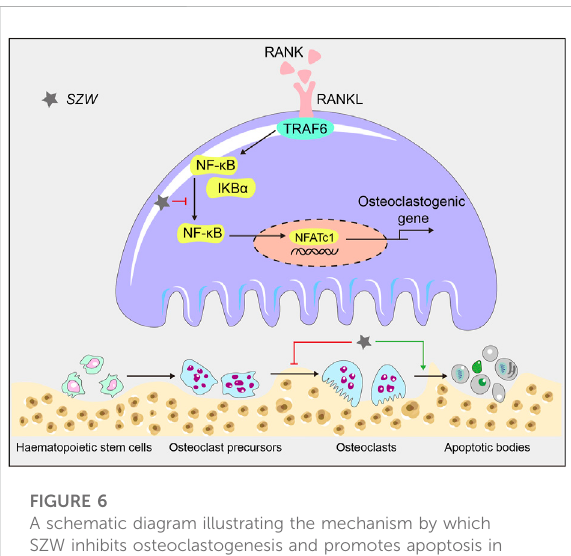
FIGURE 6 A schematic diagram illustrating the mechanism by which SZW inhibits osteoclastogenesis and promotes apoptosis in mature